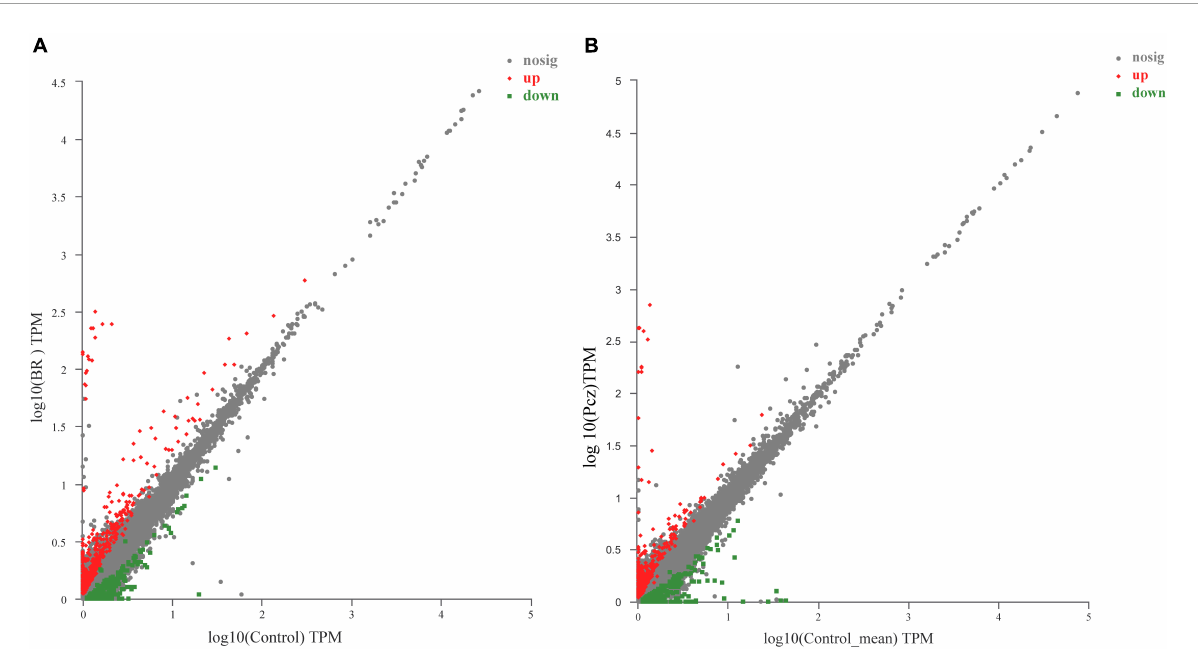
FIGURE5 Identification of differential expression genes (DEGs) among control, BR, and Pcz treatments. (A) , scatter diagram of DEGs in control and BR groups. (B) , scatter diagram of DEGs in control and Pcz groups.